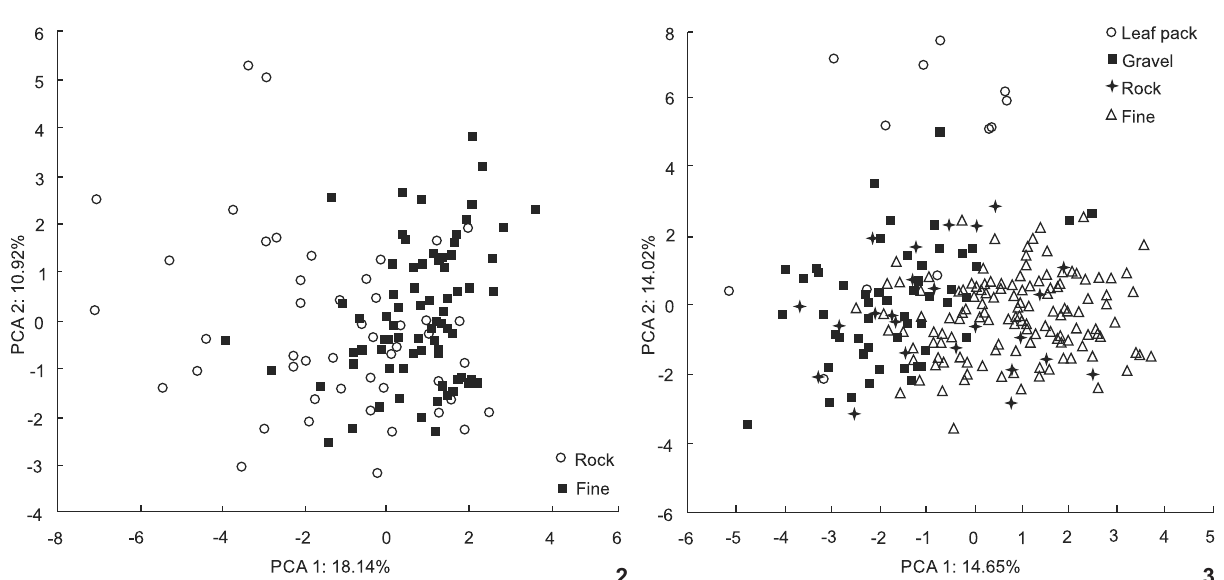
Figures 2-3. Projection of Astyanax intermedius (2) and (3) Astyanax rivularis individuals recorded in streams with different substrate types along the first two PCA axes. The axes represent the ecomorphological attributes of individuals collected in Rio São Francisco streams in September 2010 .